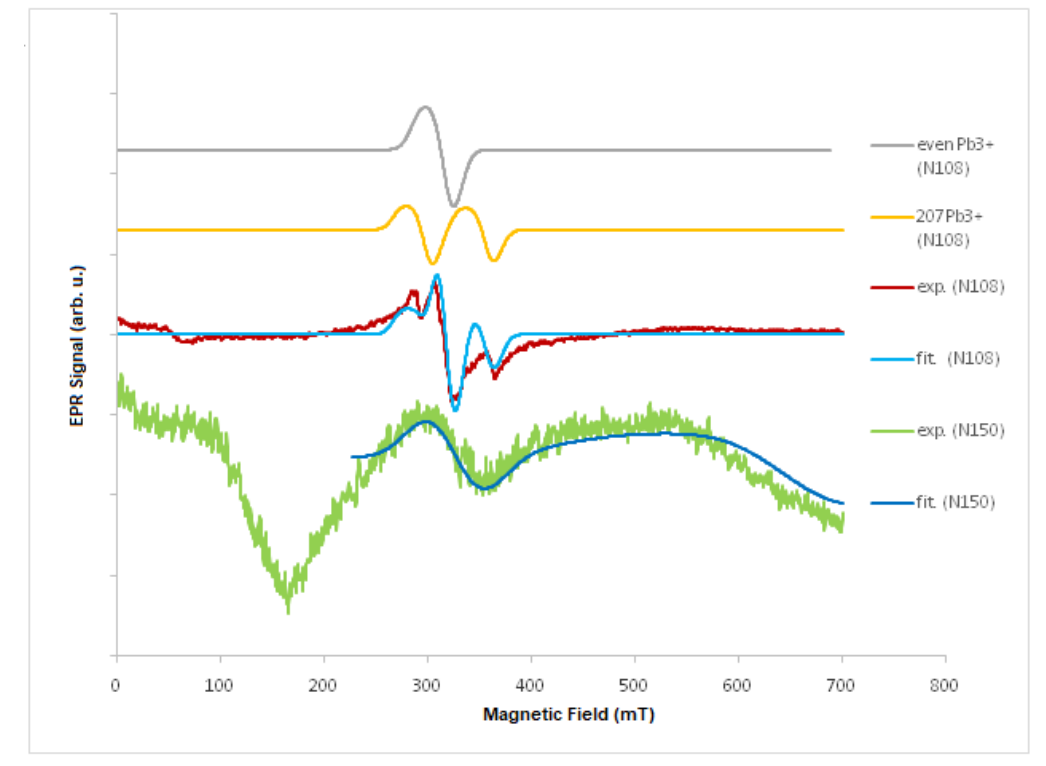
Figure 2. EPR spectra at room temperature for PbTe (N150) and PbSe (N108) experimental (exp.) and fitted (fit), as well as an example of simulated EPR spectra for 207Pb 3+ ion and even Pb isotopes (206Pb, 208Pb, and 210Pb).